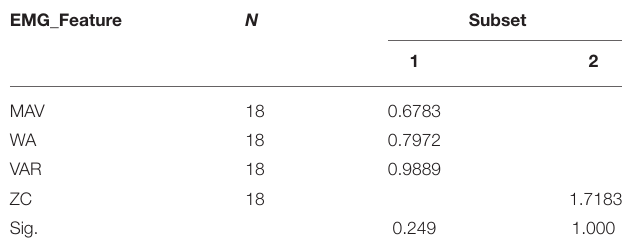
TABLE 15 | The results of the Tukey HSD for RMS.